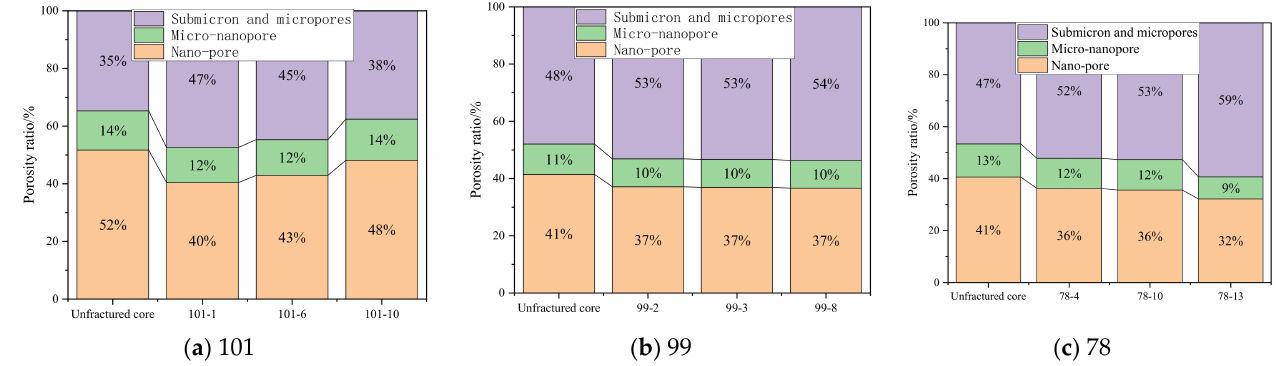
Figure 7. Comparison of the volume ratios of different pores in the cracked